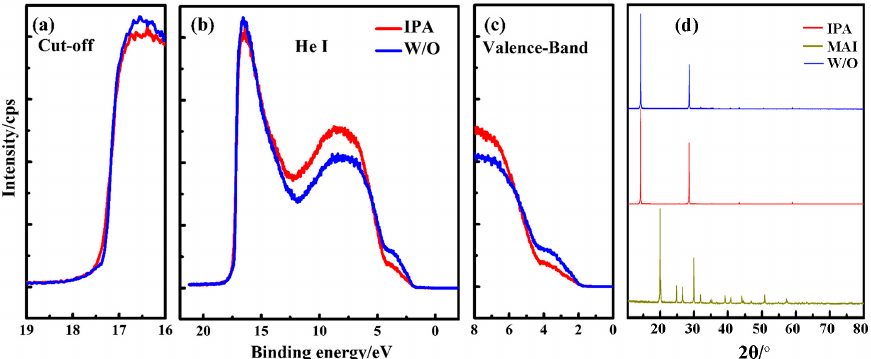
Figure 12. Ultraviolet photoelectron spectroscopy (UPS) of perovskite film with (red line) and without (blue line) IPA treatment on ITO glass substrates, i.e., ( a ) The secondary electron cut-off; ( b ) the full UPS spectrum using He I radiation; ( c ) the valence-band region; and ( d ) X-ray diffraction of perovskite film with and without IPA treatment on ITO glass substrates [113]. Copyright © 2015, Elsevier.